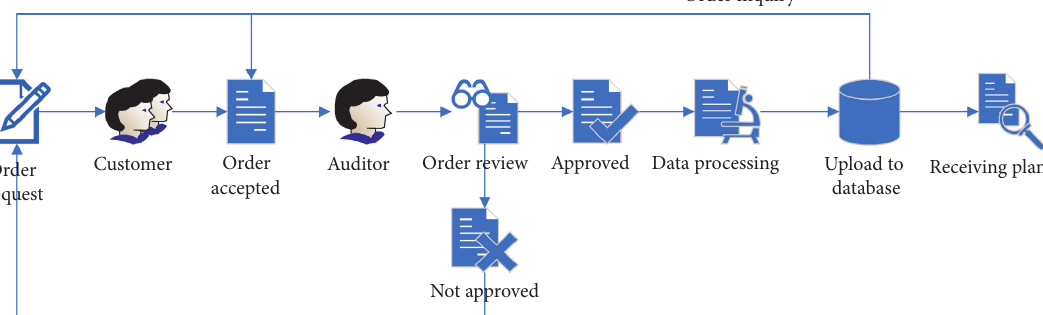
Figure 6: Order processing flow.